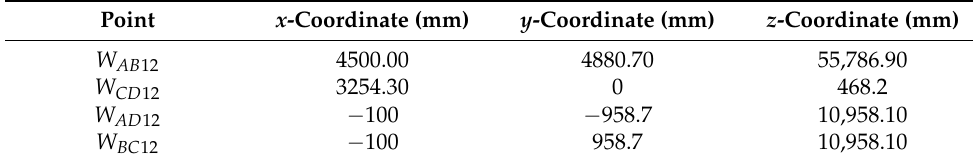
Table 3. The coordinates of the Γ 12 ’s vertices.